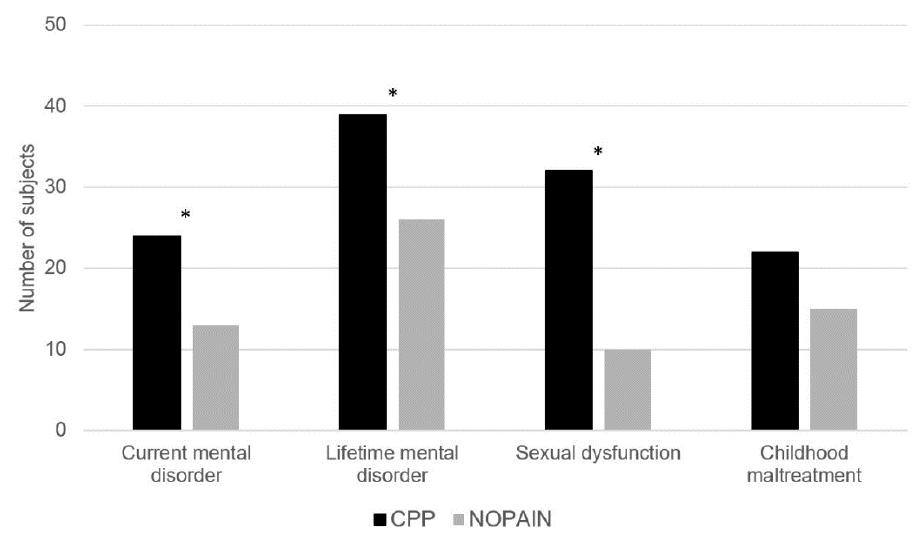
Figure 1. Rates of a current mental disorder ( p = 0.019, odds ratio OR = 2.63), a lifetime mental disorder ( p = 0.006, OR = 3.27), current sexual dysfunction ( p < 0.001, OR = 7.11) and childhood maltreatment (CM) without the subscales physical neglect and trivialization ( p = 0.074, OR = 2.04) in the groups CPP and NOPAIN. * p < 0.05. Table 2. Testing of hypotheses: comparisons of the rates of mental disorders, sexual dysfunctions and childhood maltreatment in the groups CPP and NOPAIN.